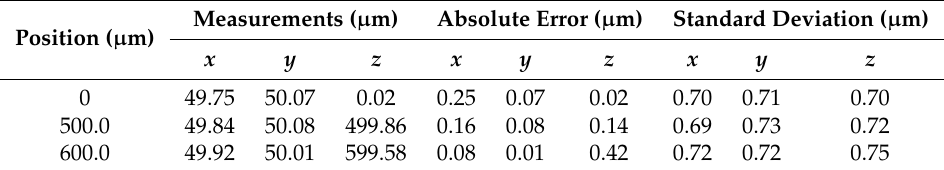
Table 1. Experimental results on precisely positioned grid arrays.